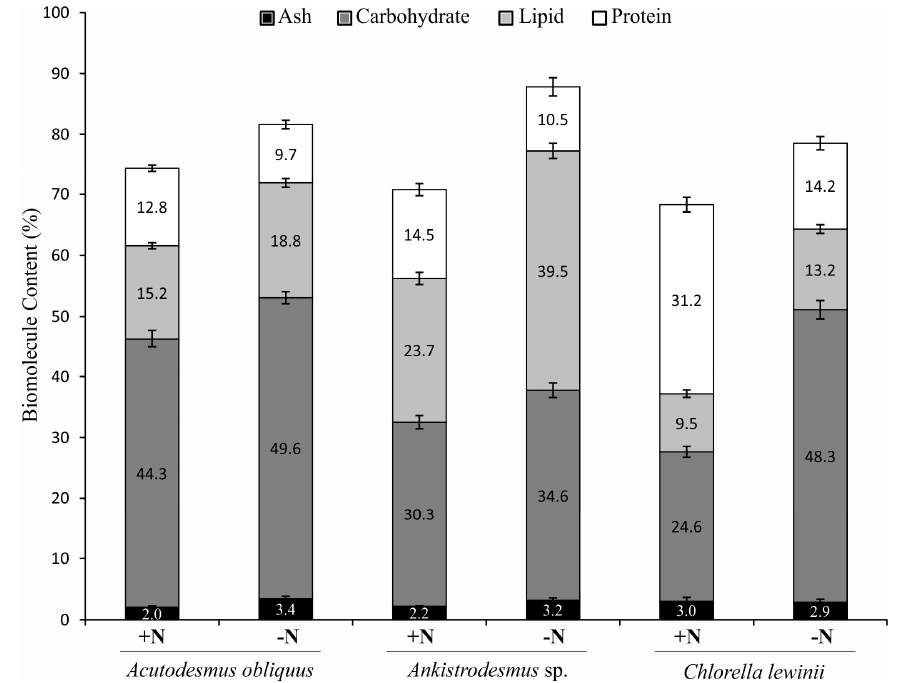
Figure 3. Biomolecule content (ash, carbohydrate, total lipid and protein) of three microalgal strains cultivated under +N and − N Chu medium No. 10. The culture was incubated in a controlled culture room at 25 ± 1 °C with 12:12-h light-dark cycles using 80 µE·m − 2 ·s − 1 intensity of cool-white fluorescent light and continuous agitation at 150 rpm. Experiments were carried out in triplicate.